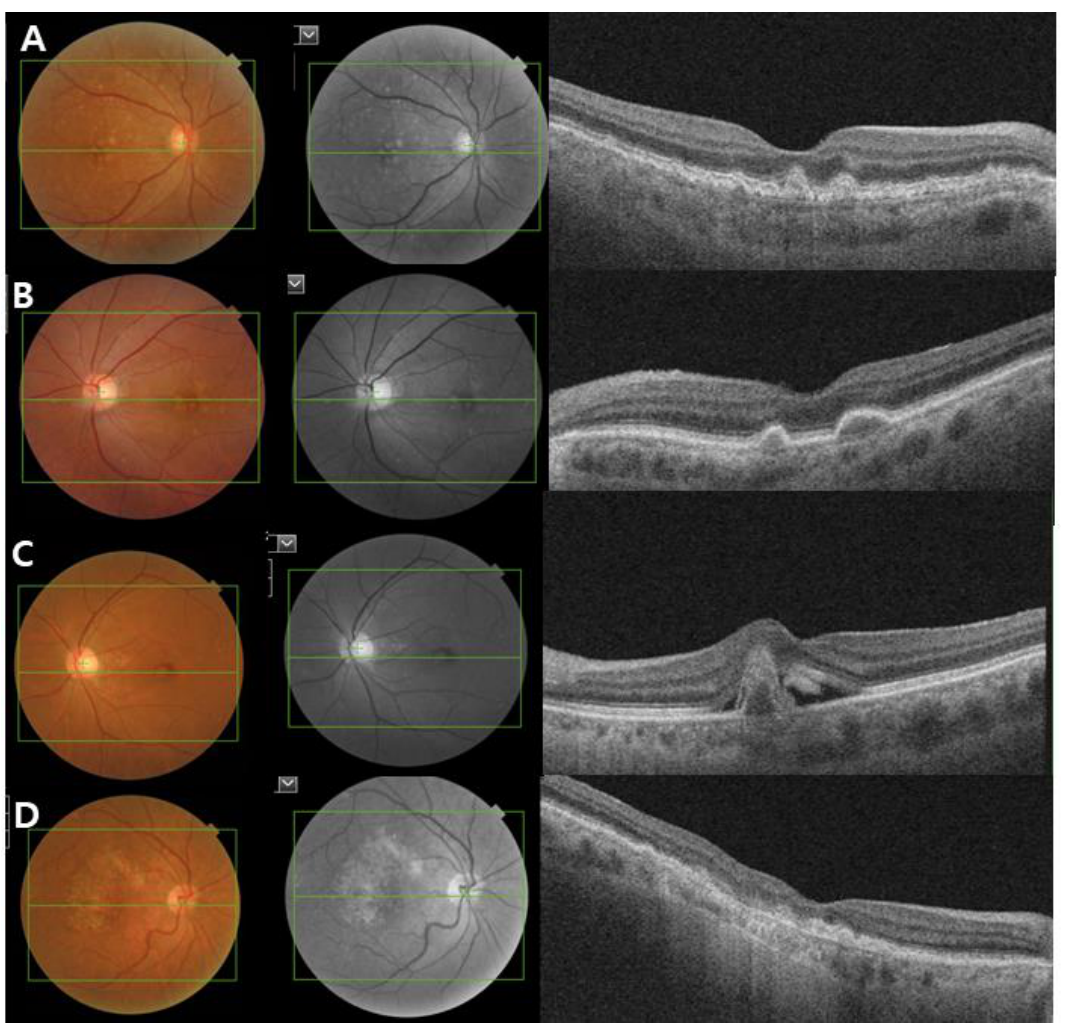
Figure 2. Clinical image of age-related macular degeneration (AMD). Color fundus photograph, red-free fundus photograph and swept-source optical coherence tomography (SS-OCT) images showing the characteristics of early and intermediate AMD ( A , B ), neovascular AMD ( C ) and geographic atrophy ( D ). ( A , B ) Non-neovascular AMD: Images showing small and intermediate soft drusen. ( C ) Neovascular AMD: subretinal fluid with subfoveal hemorrhage and a large pigment epithelial detachment. ( D ) Geographic atrophy: a well-demarcated area of fovea-involving retinal pigment epithelium atrophy.